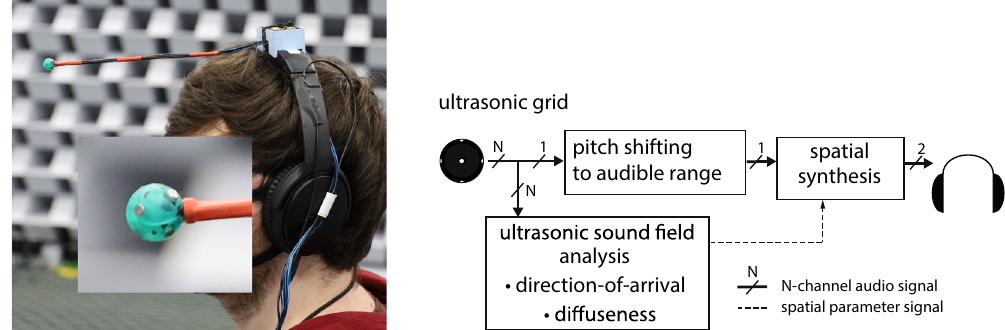
Figure 1. Left: Ultrasonic super-hearing device. Right: Signal processing chain for the